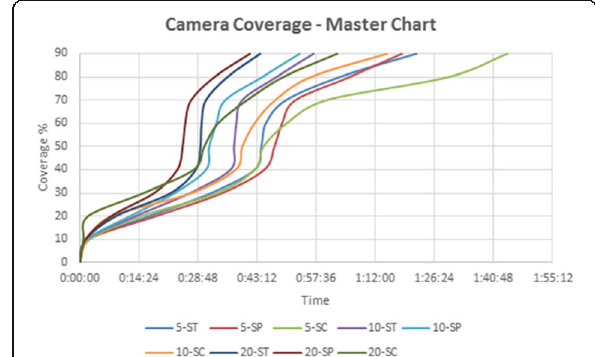
Fig. 12 Average camera coverage rates of swarms of five, 10, and 20 UAVs for all three methods shown in parallel. ST is standard , SP is spiral , and SC is scatter . Scatter method with five UAVs was the slowest and spiral method with 20 UAVs the fastest to reach the 90% coverage